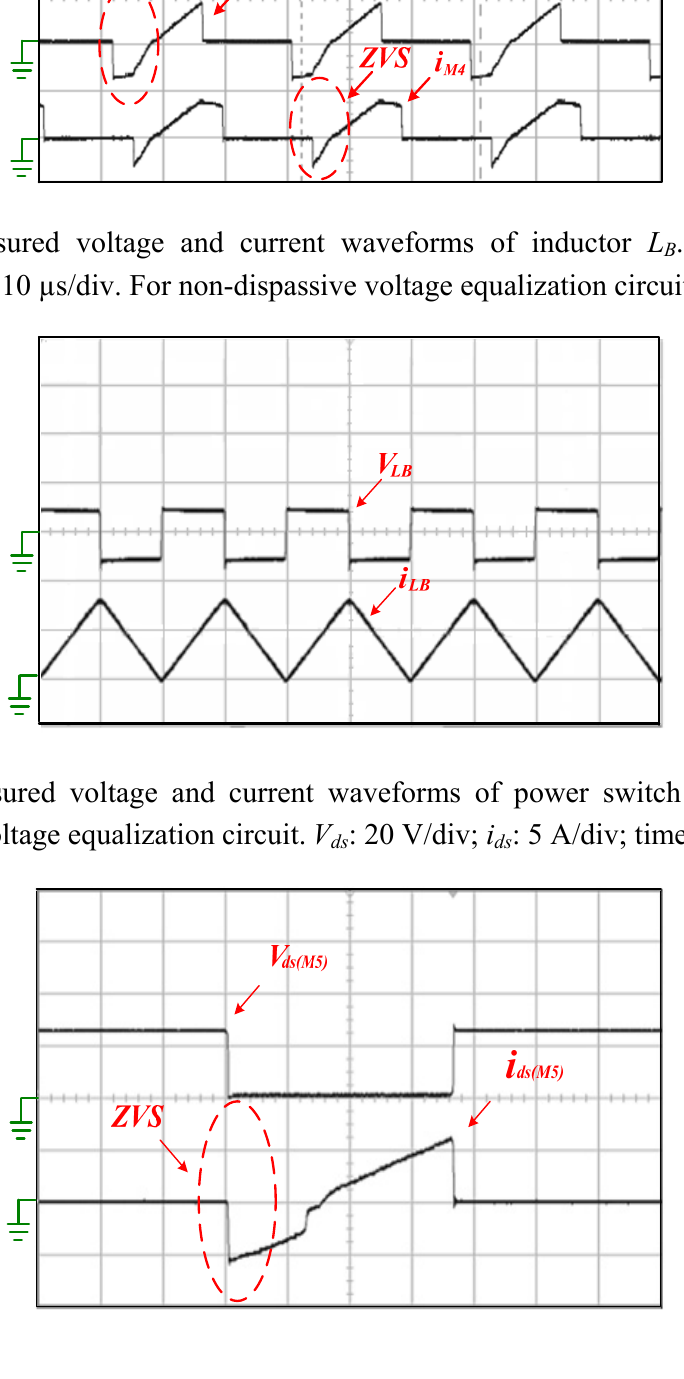
Figure 20. Measured current waveforms of power switches ( M voltage waveforms of transformer for phase-shift full-bridge converter. i V : 100 V; time: 10 µs/div. pr i